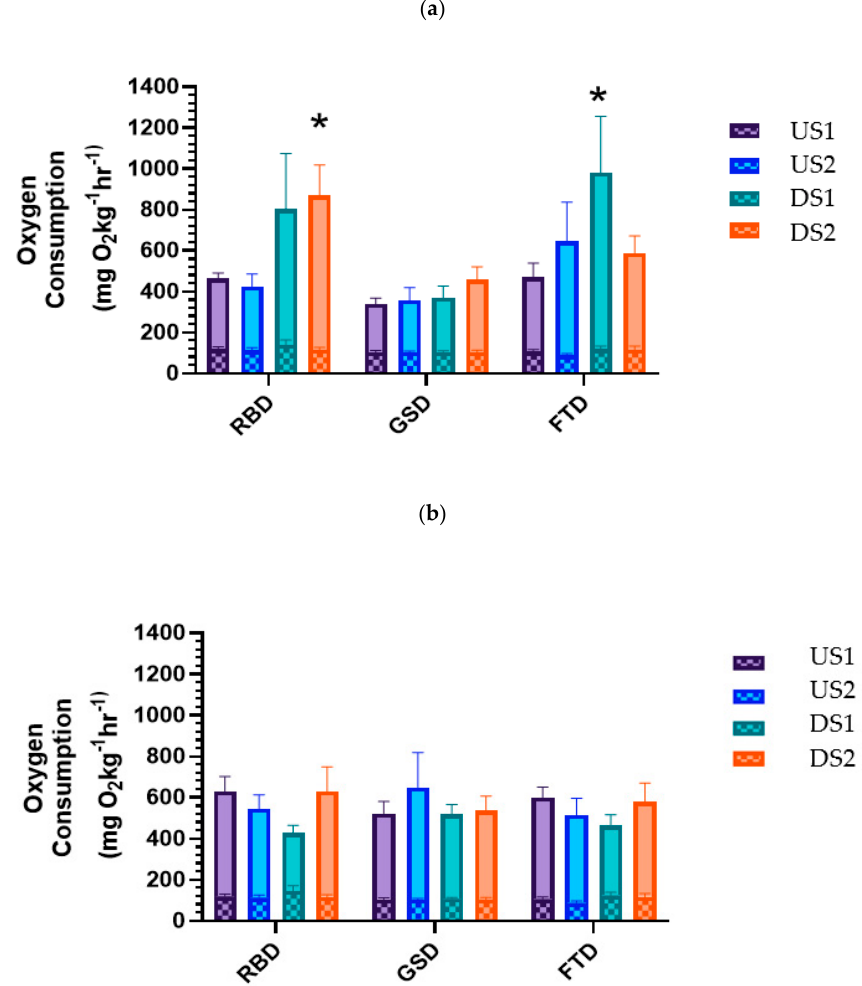
Figure 3. ( a ) Field metabolic rate (FMR) and maximum metabolic rate (MMR) of the RBDs, GSDs, and FTDs in summer 2019. ( b ) FMR and MMR of the RBDs, GSDs, and FTDs in fall 2019. Data are represented as means ± SEM (oxygen consumption—mg O 2 / kg / hr). AS is represented as the smooth area (MMR (entire bar)—FMR (checkered bar)). The Waterloo MWWTP is between US2 and DS1. An asterisk indicates a significant di ff erence ( p < 0.05) between US1 (reference site) and that location using Dunnett’s post hoc test. RBD, rainbow darter; FTD, fantail darter; GSD, greenside darter; US1, upstream 1; US2, upstream 2; DS1, downstream 1; DS2, downstream